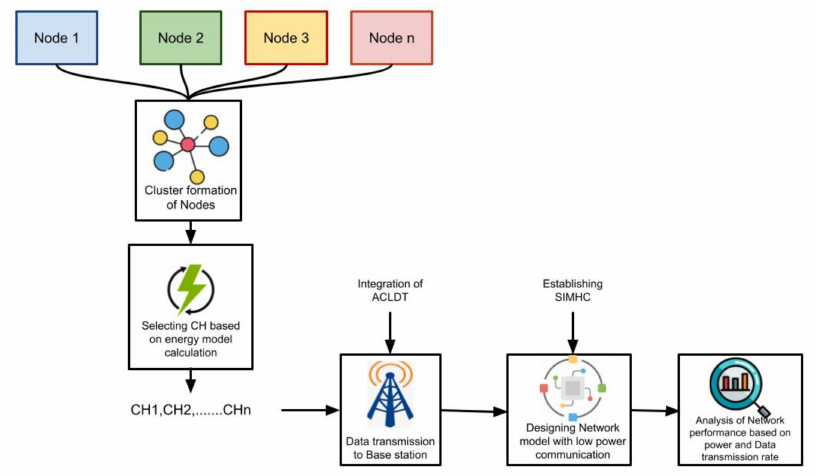
Figure 1. Overall proposed